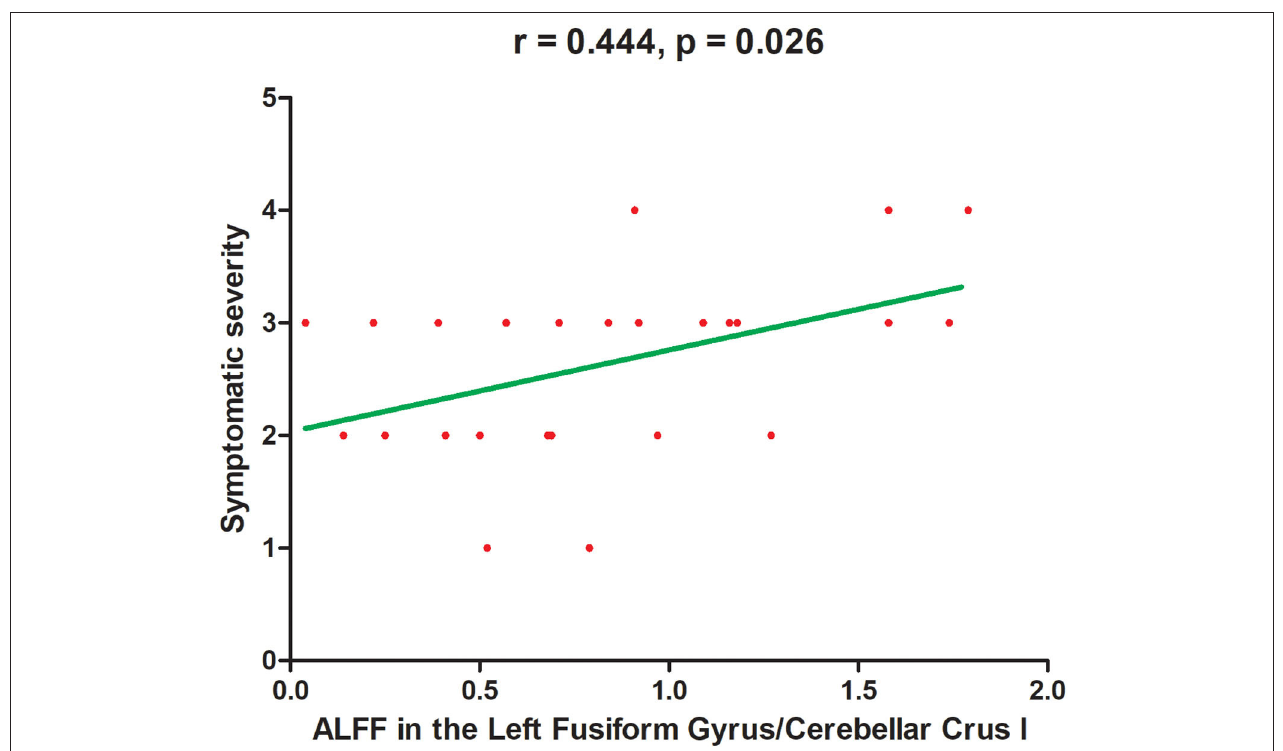
FIGURE 2 | A significantly positive correlation between symptomatic severity and ALFF values in the left fusiform gyrus/cerebellar crus I in patients with BSP. ALFF, amplitude of low-frequency fluctuations. X -axis represents ALFF z -score. Y -axis represents symptomatic severity.